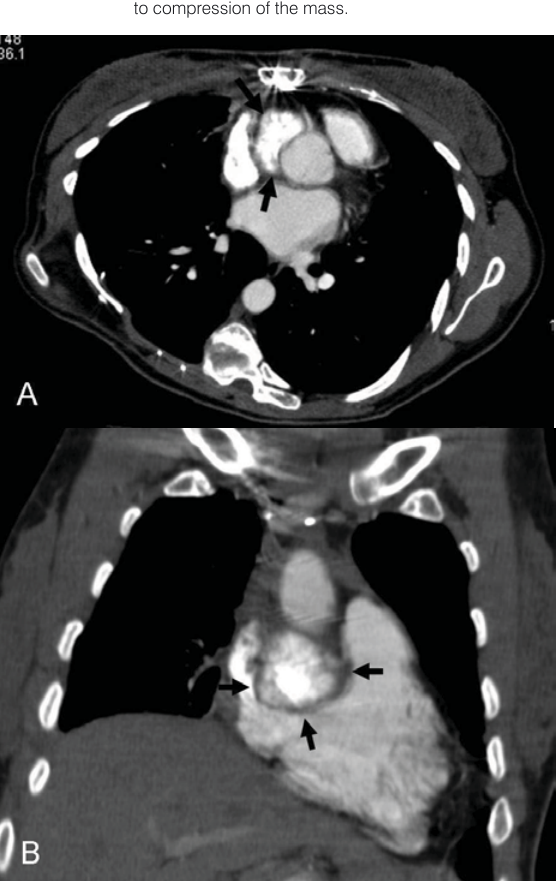
Figure 4. A, Axial contrast enhanced thorax CT image and B, coronal reformatted maximum intensity projection image demonstrates a right paraaortic calcific mass extending between aortic root and the right atrial appendage (arrows). Note that right coronary artery is deplased due to compression of the mass.